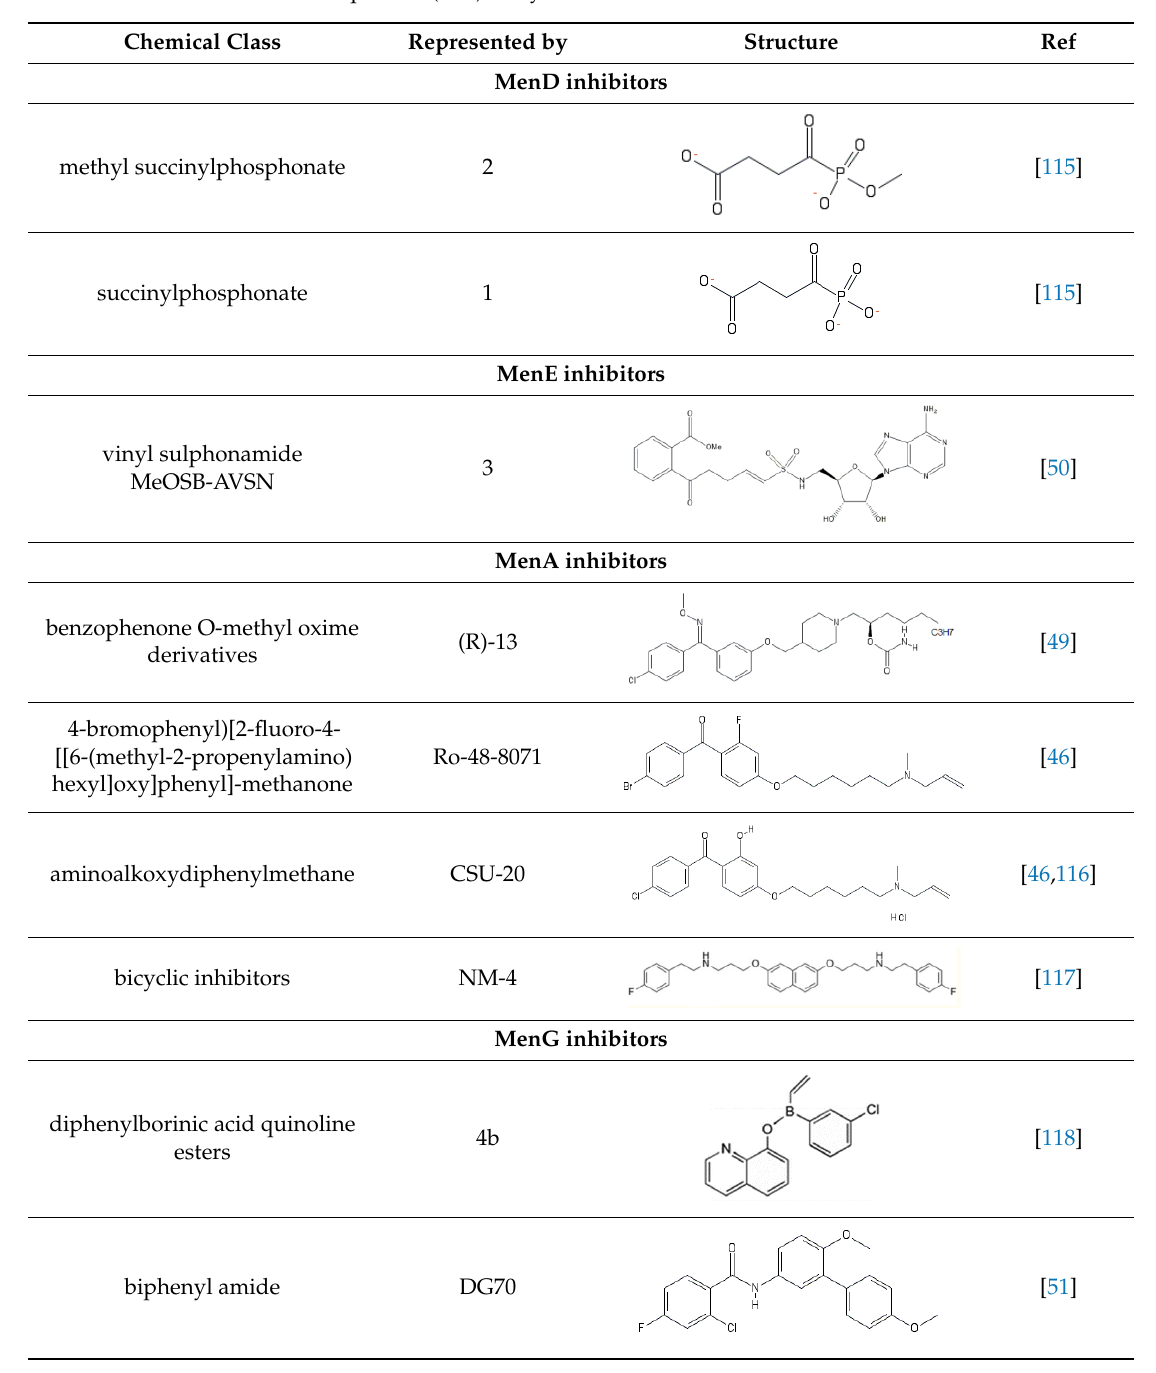
Table 2. Menaquinone (MK) biosynthesis inhibitors discussed in this review.